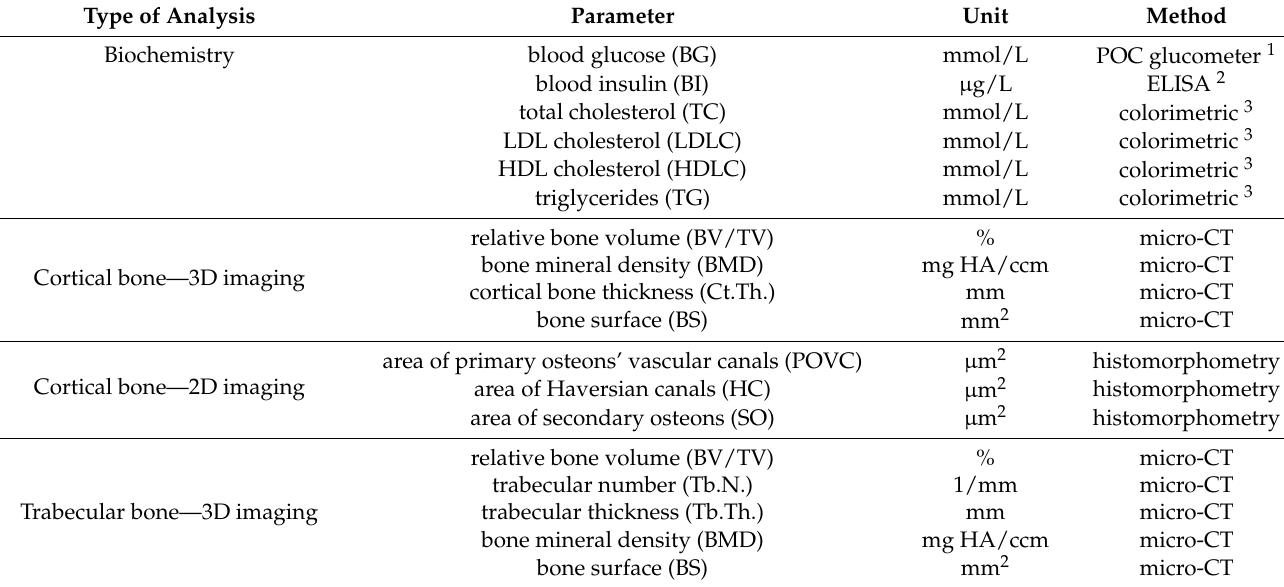
Table 2. Measured parameters from biochemical and morphological 3D and 2D analyses. Type of